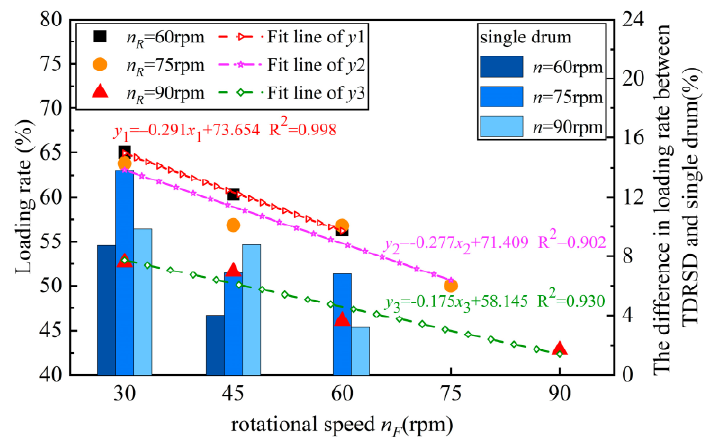
Figure 16. The loading rate difference between the single drum and TDRSD with the same n R